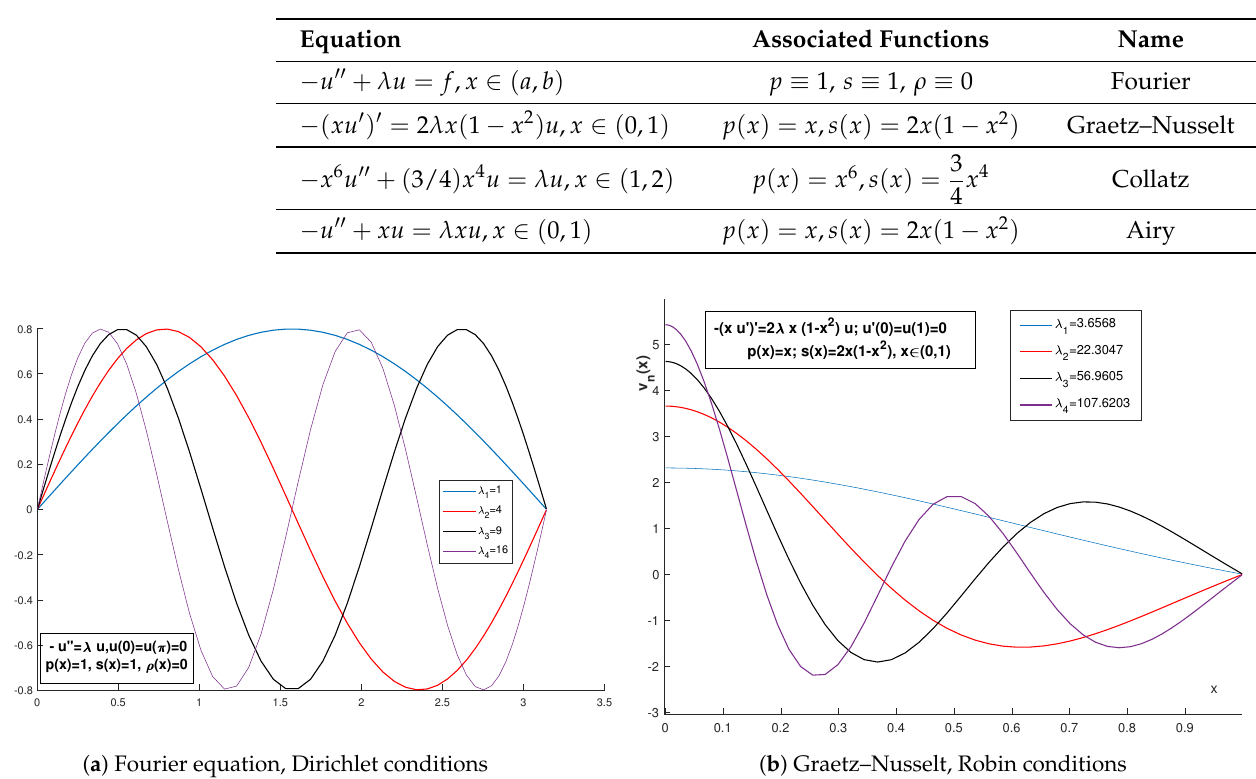
Figure 1. ( a ) Fourier equation; ( b ) Graetz–Nusselt